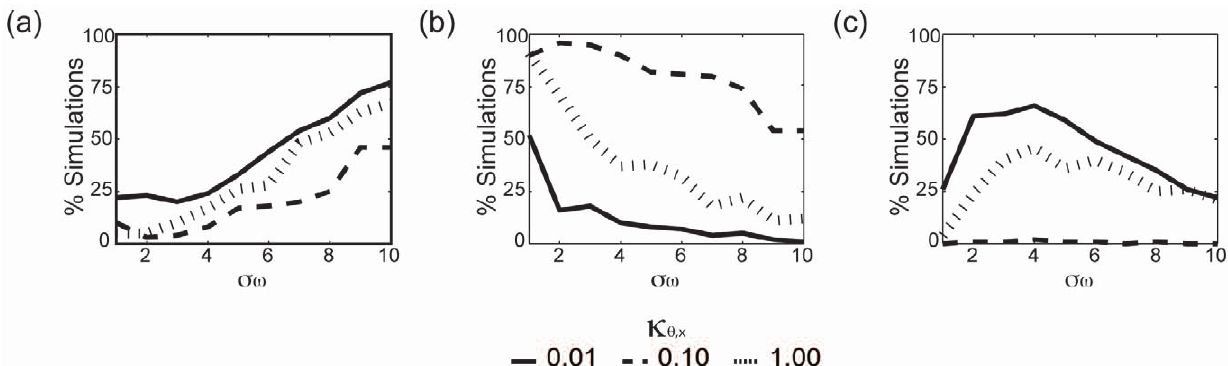
Figure 2. Percentage of simulations in which the qualitative dynamics in Figure 1 occur. In (a) oscillators synchronize and switches are ‘‘on’’, in (b) oscillators freeze and switches are ‘‘off’’, and in (c) switches vary with oscillators vs s v for k h , x ~ 0 : 01 (solid), k h , x ~ 0 : 1 (dotted) and k h , x ~ 1 (dashed). k x , x ~ 1 v ^ kk x , x , k x , h ~ 1 : 5 , and k h , h ~ 40 w ^ kk h , h .